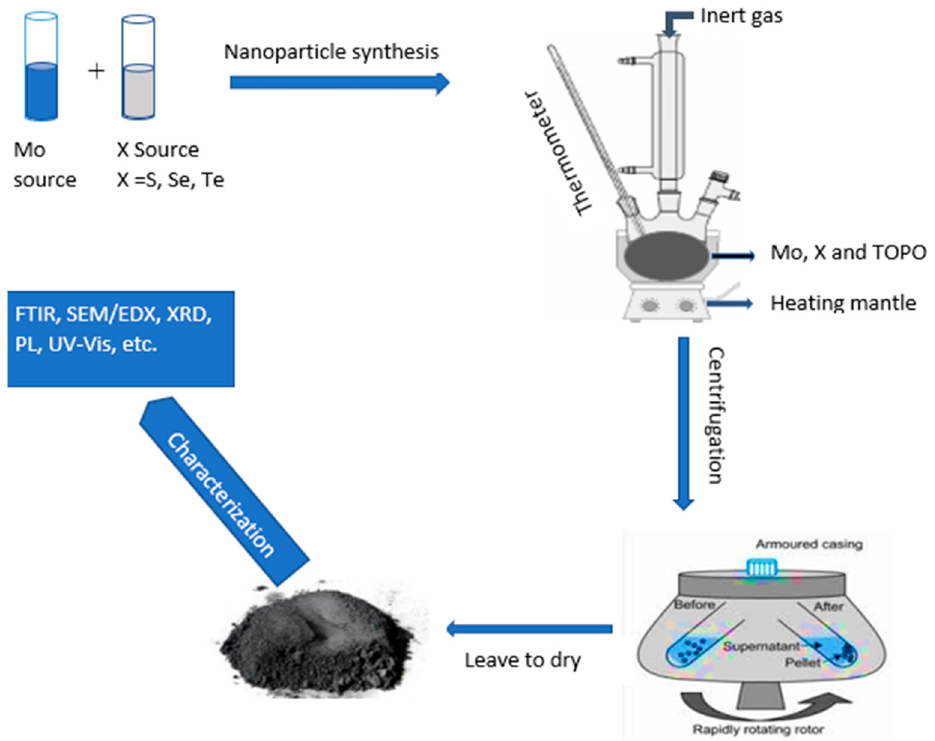
Figure 7. Synthesis procedure for the molybdenum chalcogenide nanoparticles from two-source precursors .